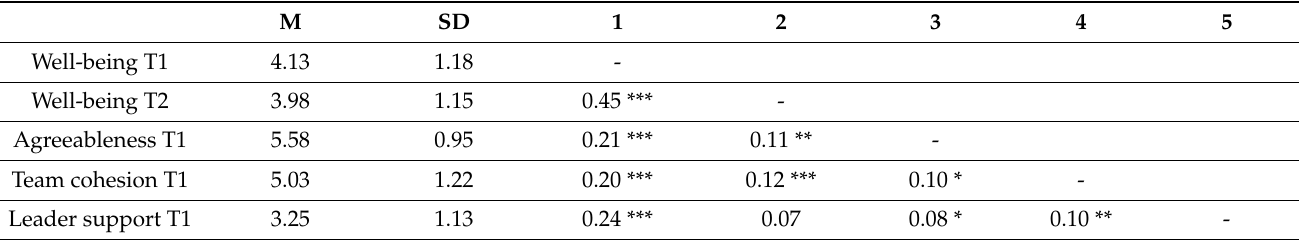
Table 1. Descriptive statistics and correlations among the research variables ( N =